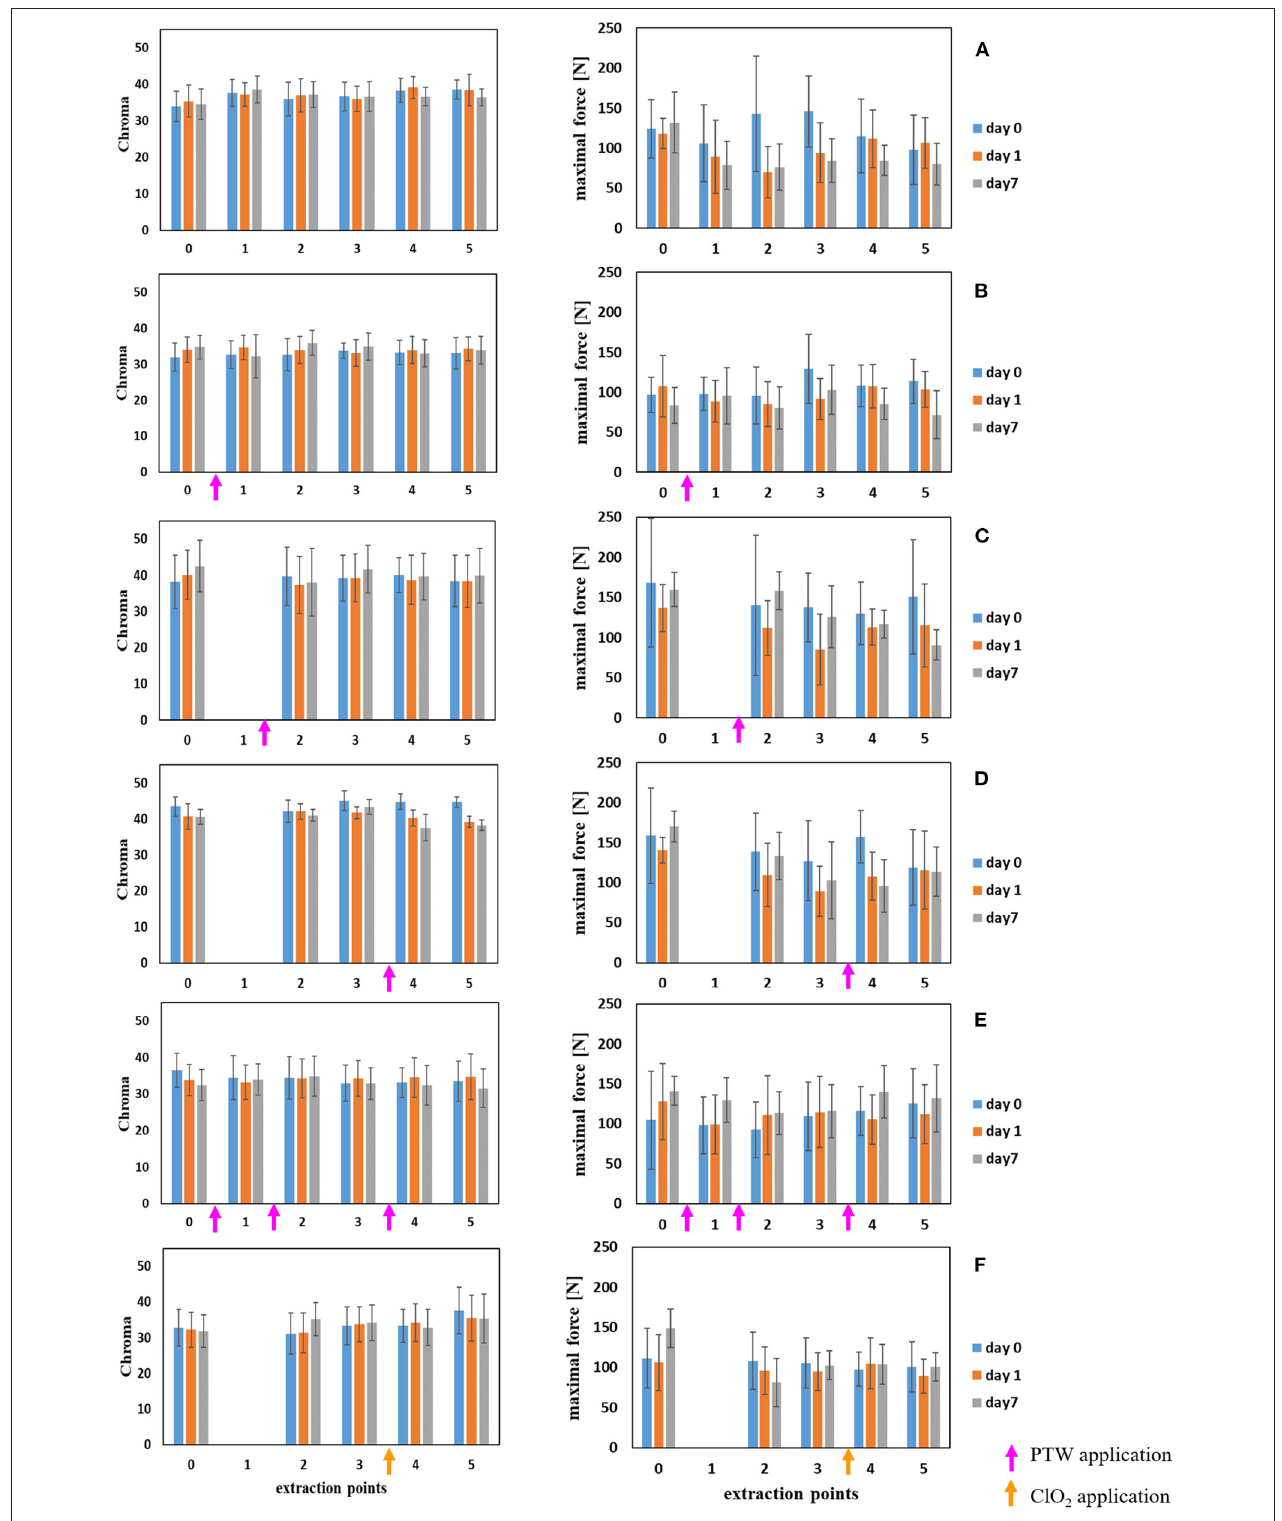
FIGURE 2 | The effect of unit process treatments on color and texture stability of fresh cut endive. Color (left column) and texture measurements (right column) of unwashed (extraction point 0) and tap water, PTW or ClO 2 washed fresh-cut endive (extraction points 1–5). (A) Variant I: tap water at all extraction points for